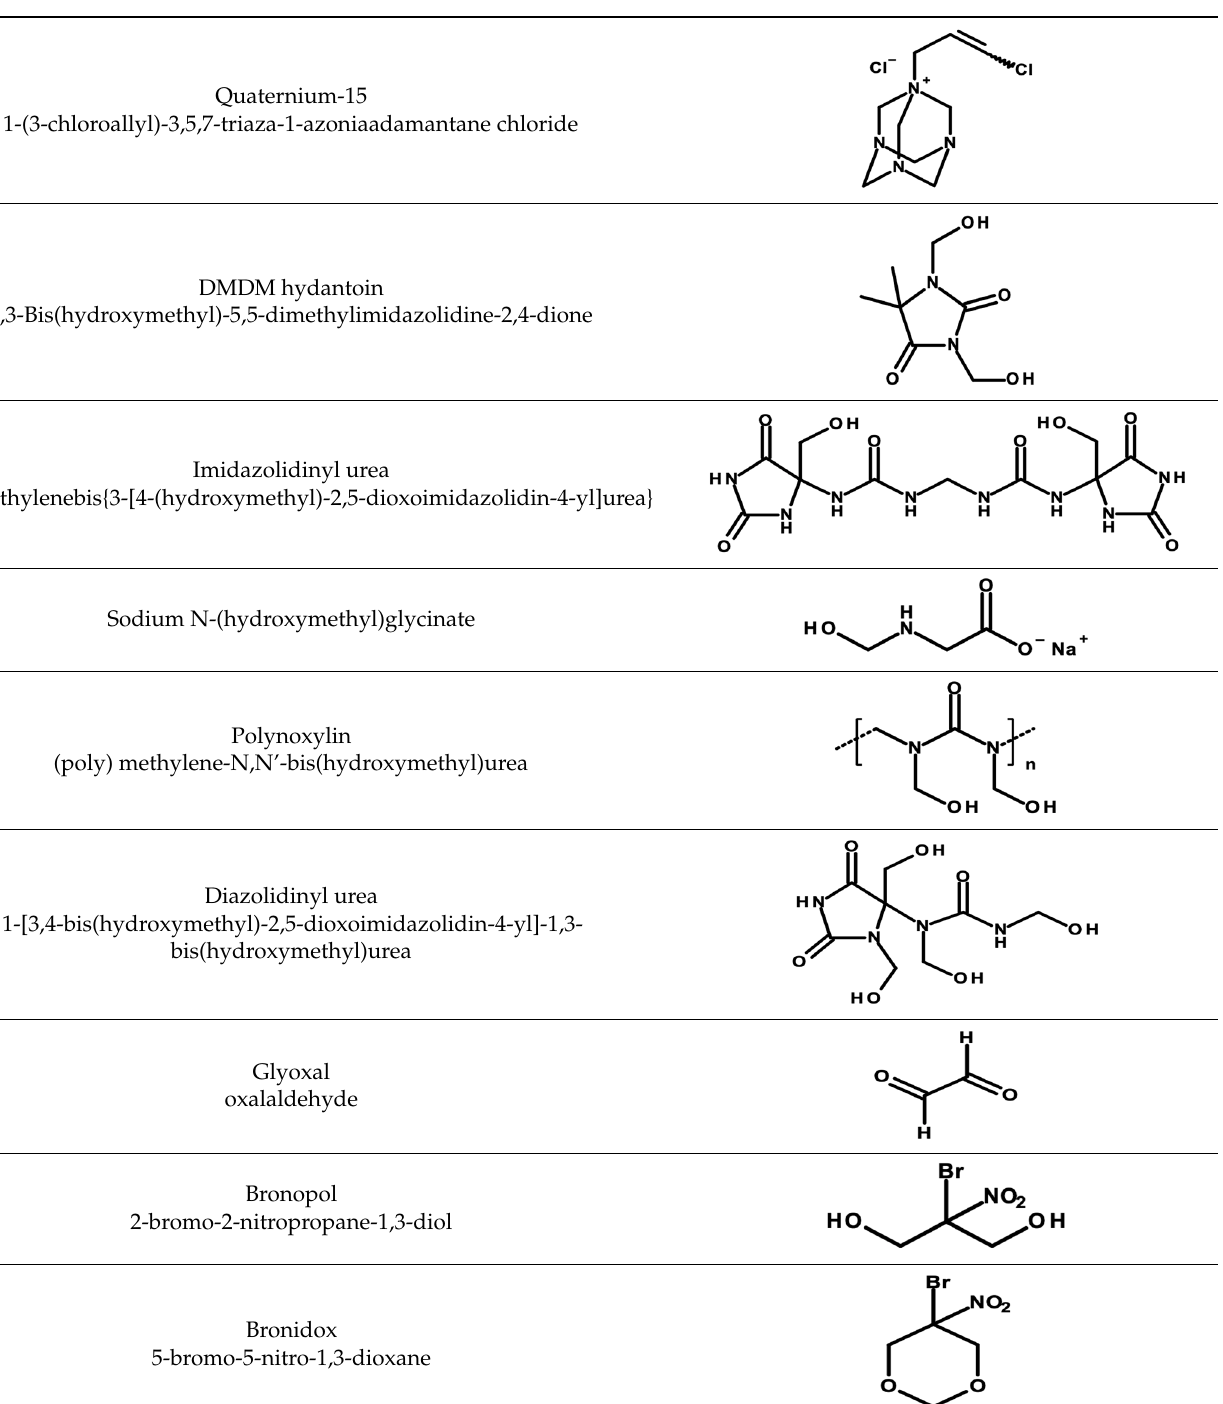
Table 4. Chemical structure of formaldehyde donors.